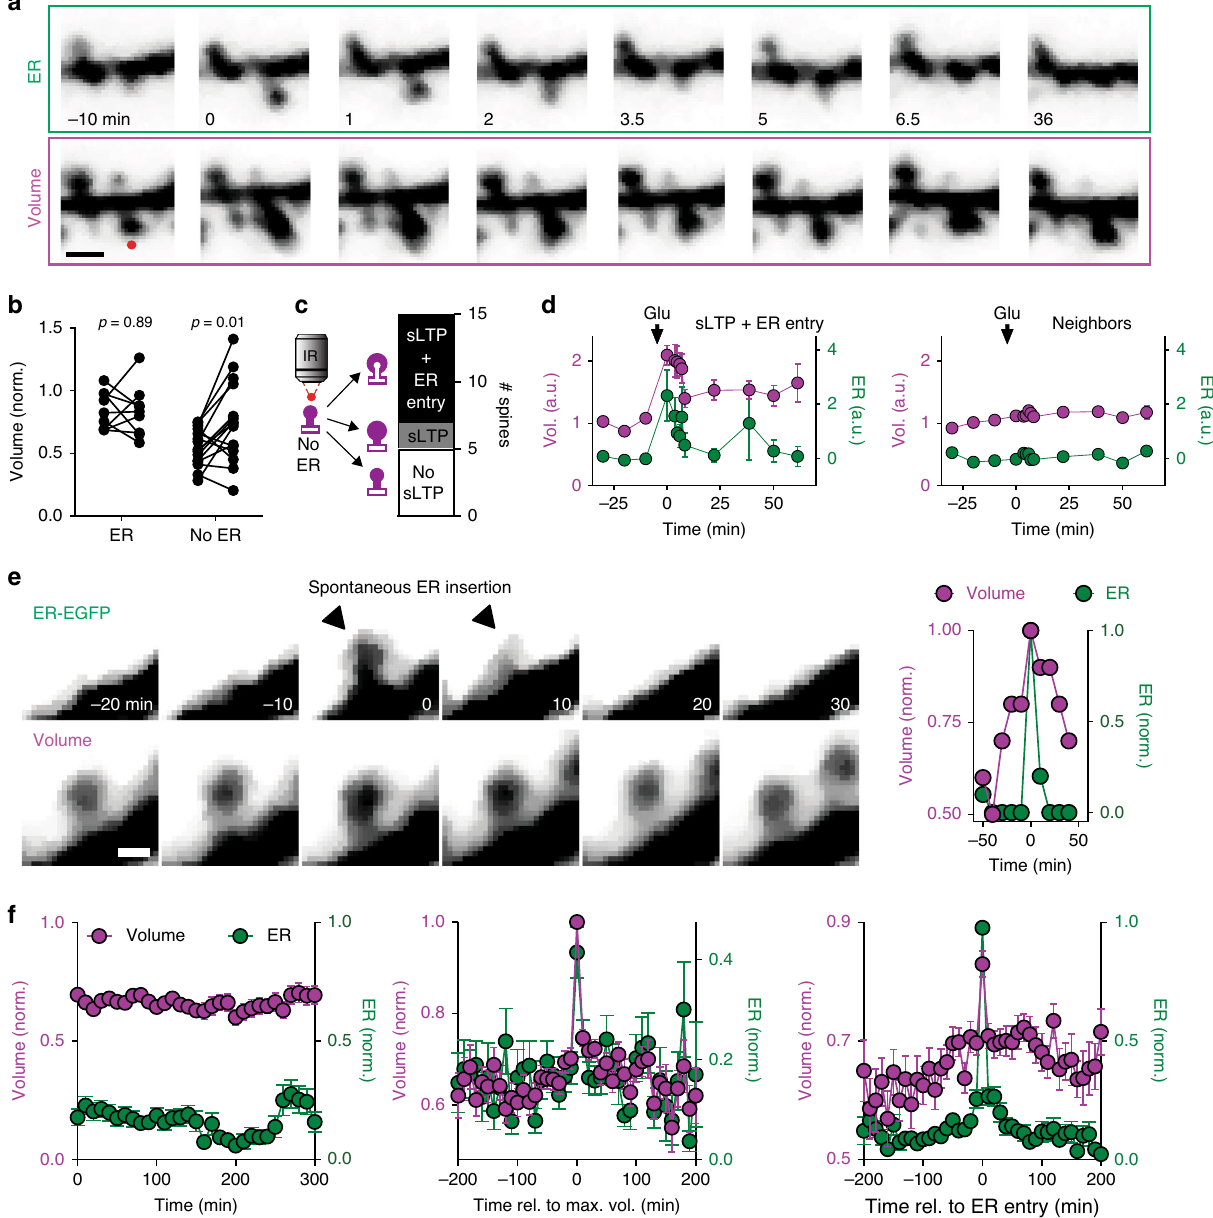
Fig. 2 Spine structural plasticity triggers ER visits. a Time-lapse imaging of tdimer2 (spine volume) and ER-EGFP fl uorescence during a glutamate uncaging experiment in zero Mg 2 + . Red dot denotes location of uncaging spot immediately before t = 0. Scale bar: 1 µ m. Experiment was reproduced eight times. b Size of spines (normalized to local dendrite) before and after glutamate uncaging. Spines without ER were smaller (0.55 ± 0.04, n = 15 spines, 3 cells, 3 slices) than those containing ER (0.84 ± 0.05, n = 9 spines, 3 cells, 3 slices) ( p = 0.0001, two-sided unpaired t -test). Spines without ER responded with a volume increase to uncaging (0.75 ± 0.08, n = 15, p = 0.01, two-sided paired t -test), while ER spines remained largely unchanged (0.83 ± 0.07, n = 9, p = 0.89, two-sided paired t -test). c Lasting volume increase (sLTP, ten spines) was typically associated with ER entry (eight of ten spines). Spines that did not show sLTP ( fi ve spines) also did not attract ER. d Average volume and ER signal (normalized to pre-uncaging) of stimulated spines undergoing structural LTP and ER insertion ( n = 8 spines) and immediate neighbors ( n = 39 spines) upon glutamate uncaging. Arrows indicate time of glutamate uncaging. Markers and error bars represent mean ± SEM. e Example of a spine receiving a brief ER visit during a volume maximum. Scale bar: 1 µ m. This behavior was reproduced on spines from three slices. f Averaging spine volume traces over the entire observation period shows stable average volume and stable probability of ER visits (left). Aligning spine volume traces by the time of maximum spine volume ( t = 0) reveals coincident ER entry, but no lasting structural plasticity following the entry event (middle). Aligning traces by maximum ER signal upon entry reveals simultaneous spine head volume maximum (right). Prior to averaging, fl uorescence intensity over time was normalized to the maximum fl uorescence measured in each spine. Datapoints are mean ± SEM from n = 65 spines (3 slices). Source data are provided as a Source Data fi